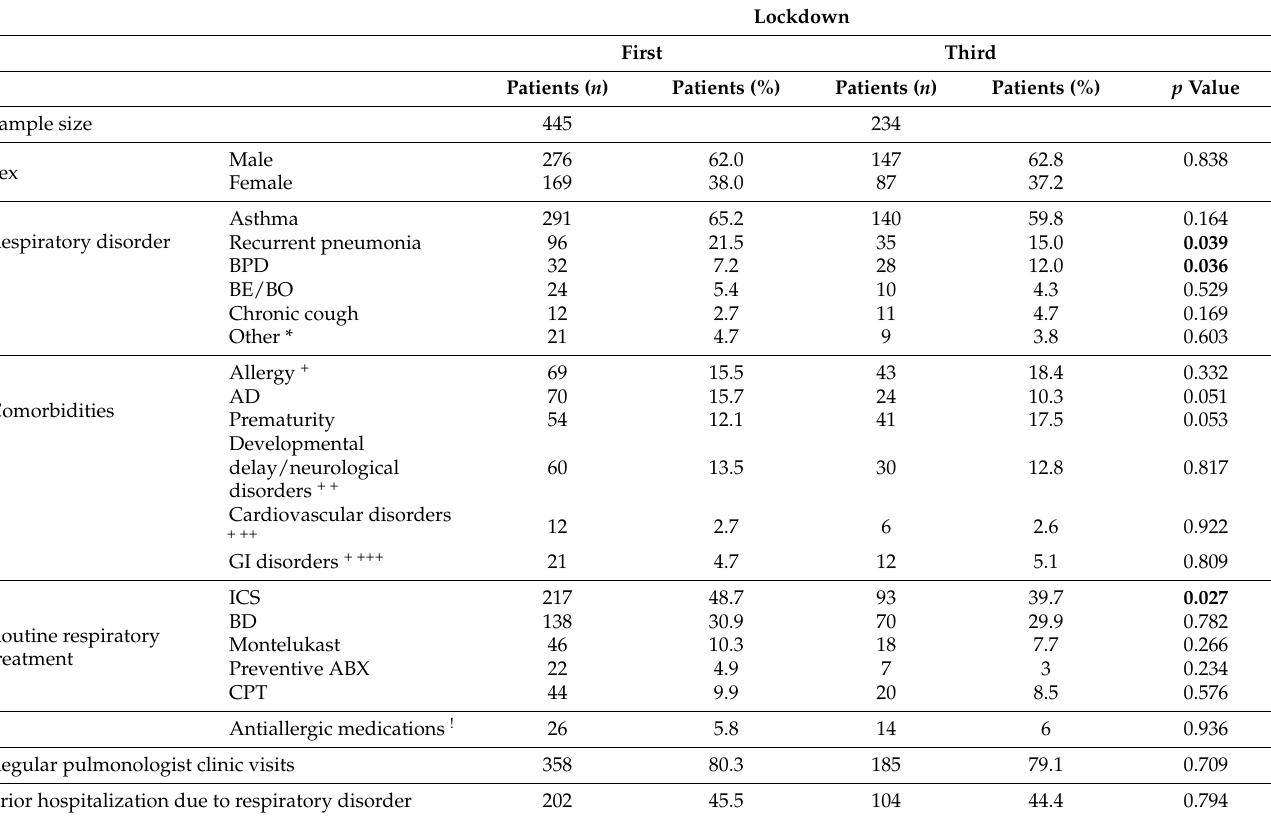
Table 1. Demographic and baseline medical status.